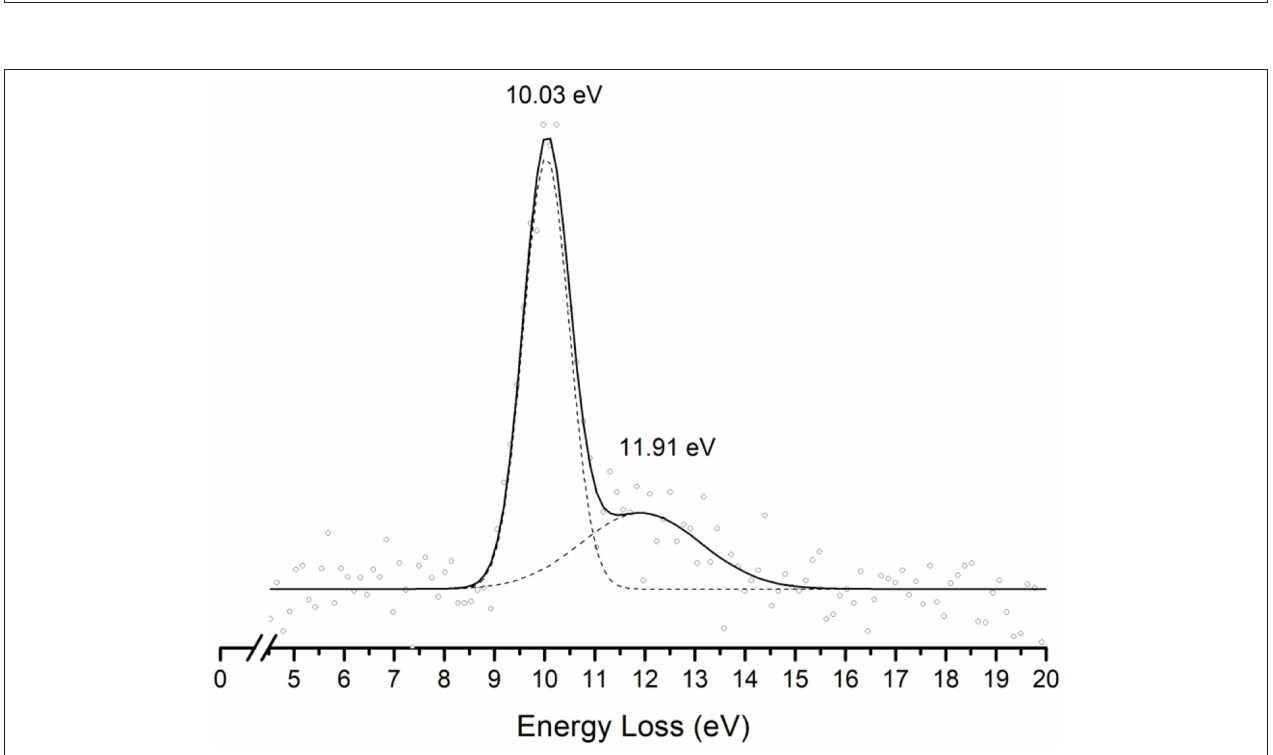
Frontiers in Chemistry |